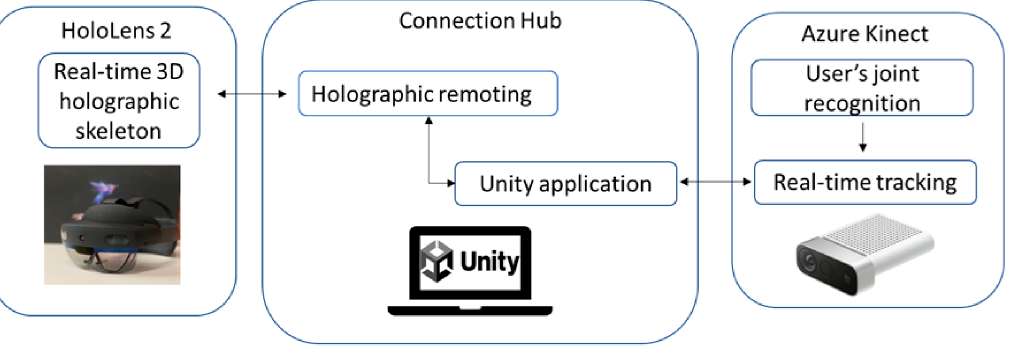
Figure 3. Block diagram of the system architecture and the functioning of each